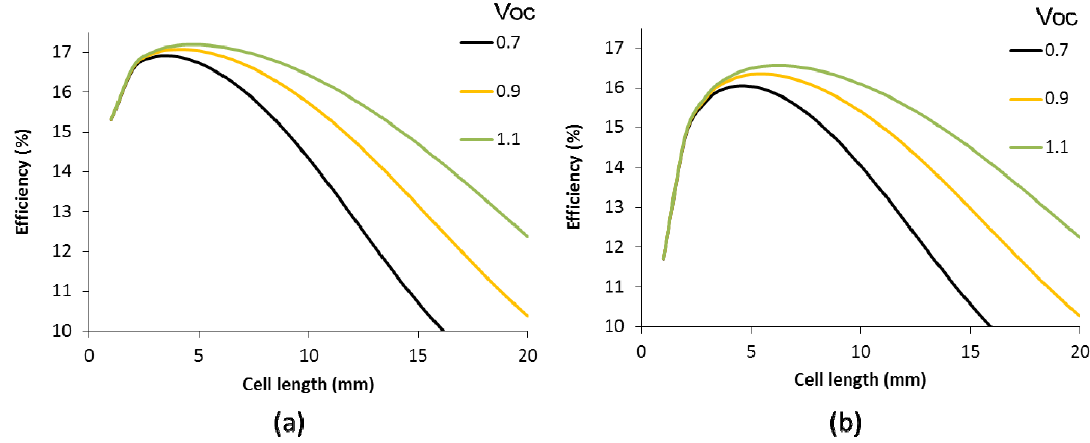
Figure 5. Efficiency of solar panels as a function of the individual cell length for different open circuit voltages (Voc in V) for a scribe width of 150 μ m ( a ) and 350 μ m ( b ). The front contact consists of a TCO of 10 Ω /sq.